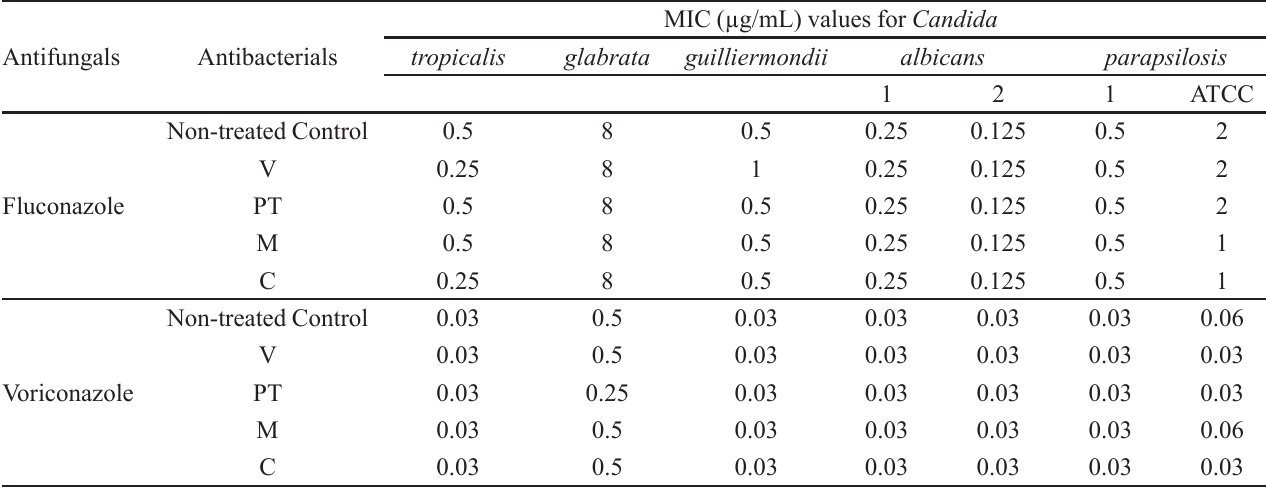
TABLE I – In vitro susceptibility test with voriconazole and fluconazole for Candida species pre-treated with cell-wall targeted